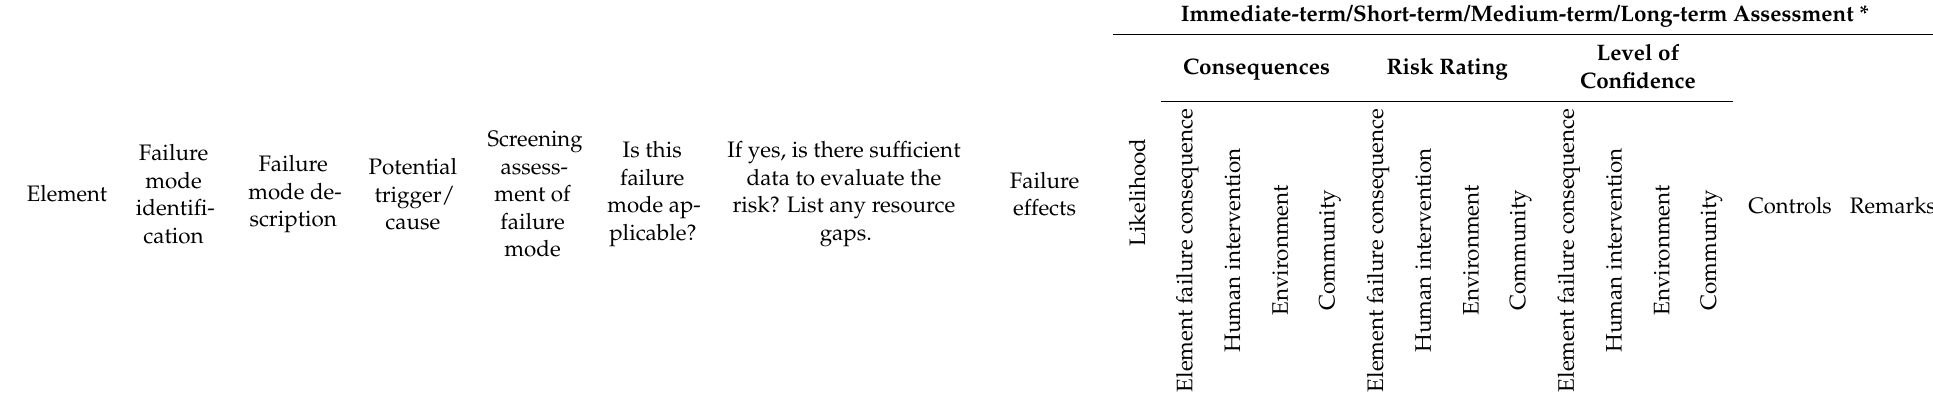
Table A1. Recommended G-FMEA worksheet (Reprinted from Schafer et al. [2]).